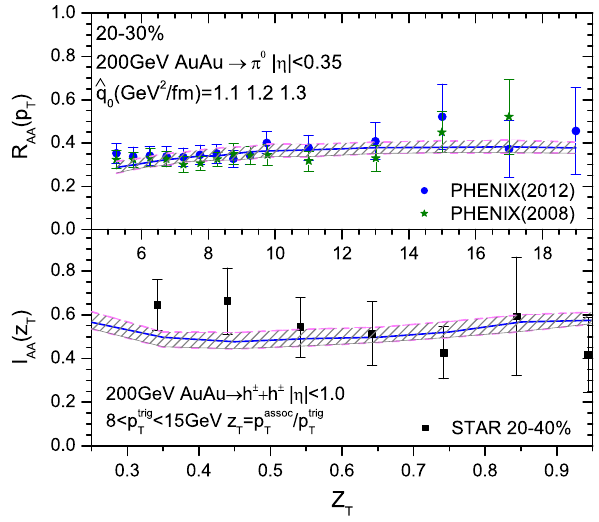
Fig. 3 The single hadron and dihadron suppression factors in mid- √ s NN = 0 . 2 TeV compared with PHENIX central Au+Au collisions at [33,34] and STAR [35]